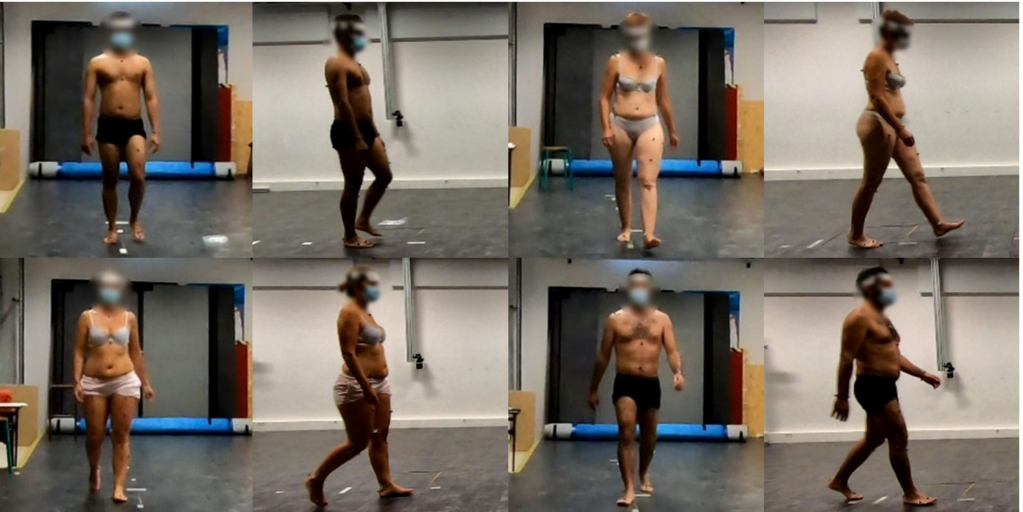
Figure 3. Example images of the ENSAM Pose dataset after face